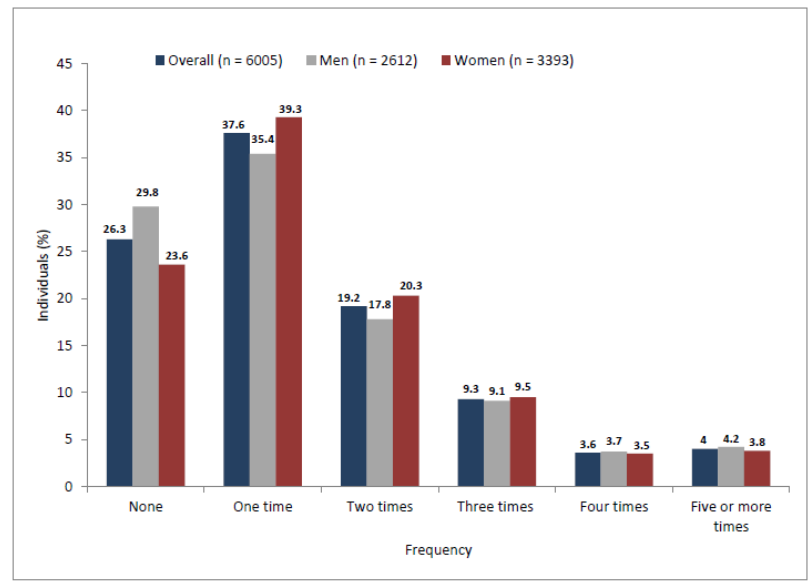
Figure 1. Prevalence of nocturia.